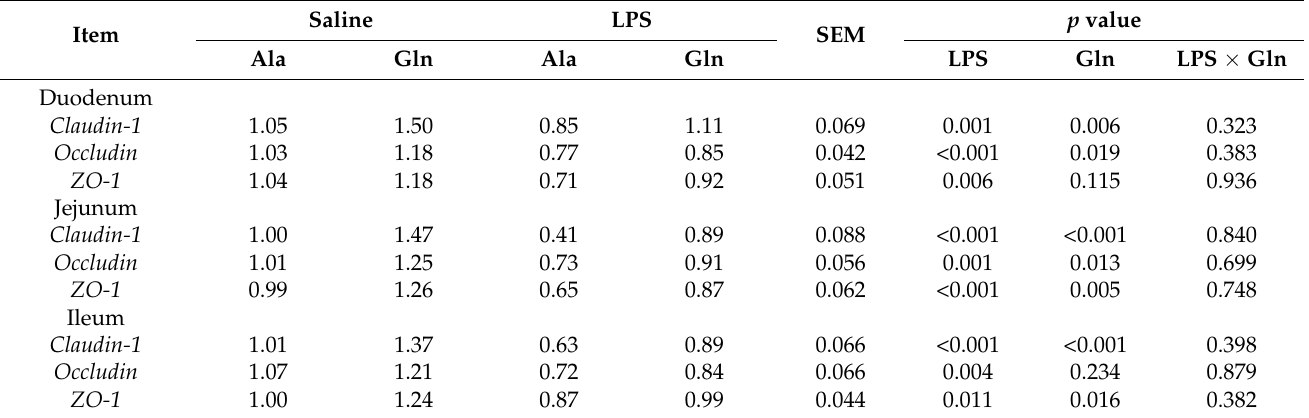
Table 5. Effects of dietary Gln supplementation on mRNA expression of tight junction adhension of intestine of broilers challenged with LPS 1